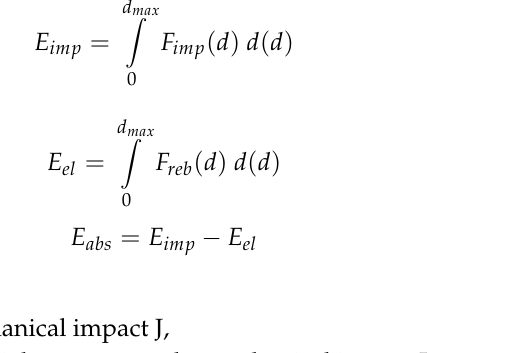
Figure 8. Average water content, WSB% , in the beet roots in the surrounding impact sites depending on the storage day. A decrease in water content in the studied samples in the analyzed storage period was observed. Moreover, a statistical dependence between the moisture content and stor- age time with a correlation coefficient of R 2 = 0.94 was found. In the impact tests, the height of the drop increases the impact velocity; therefore, the obtained dependence of the maximal impact force on velocity can be directly attributed to the drop height. Figure 9 presents the dependence of the maximal force of root response F max on the impact velocity V imp , taking the storage time into account. An increase in max- imal values of forces with increasing impact velocity was found for all groups of roots stored from 0 to 5 days. The maximal impact force reached the following mean values for fresh roots: 389.3 N for 0.5 m·s −1 velocity, 870.5 N for 1.0 m·s −1 and 1274.4 N for 1.5 m·s −1 . The values of forces decreased on successive days for all impact velocities, and F max reached the following mean values for 5-day-old roots: 259.0 N for the velocity 0.5 m·s −1 ,